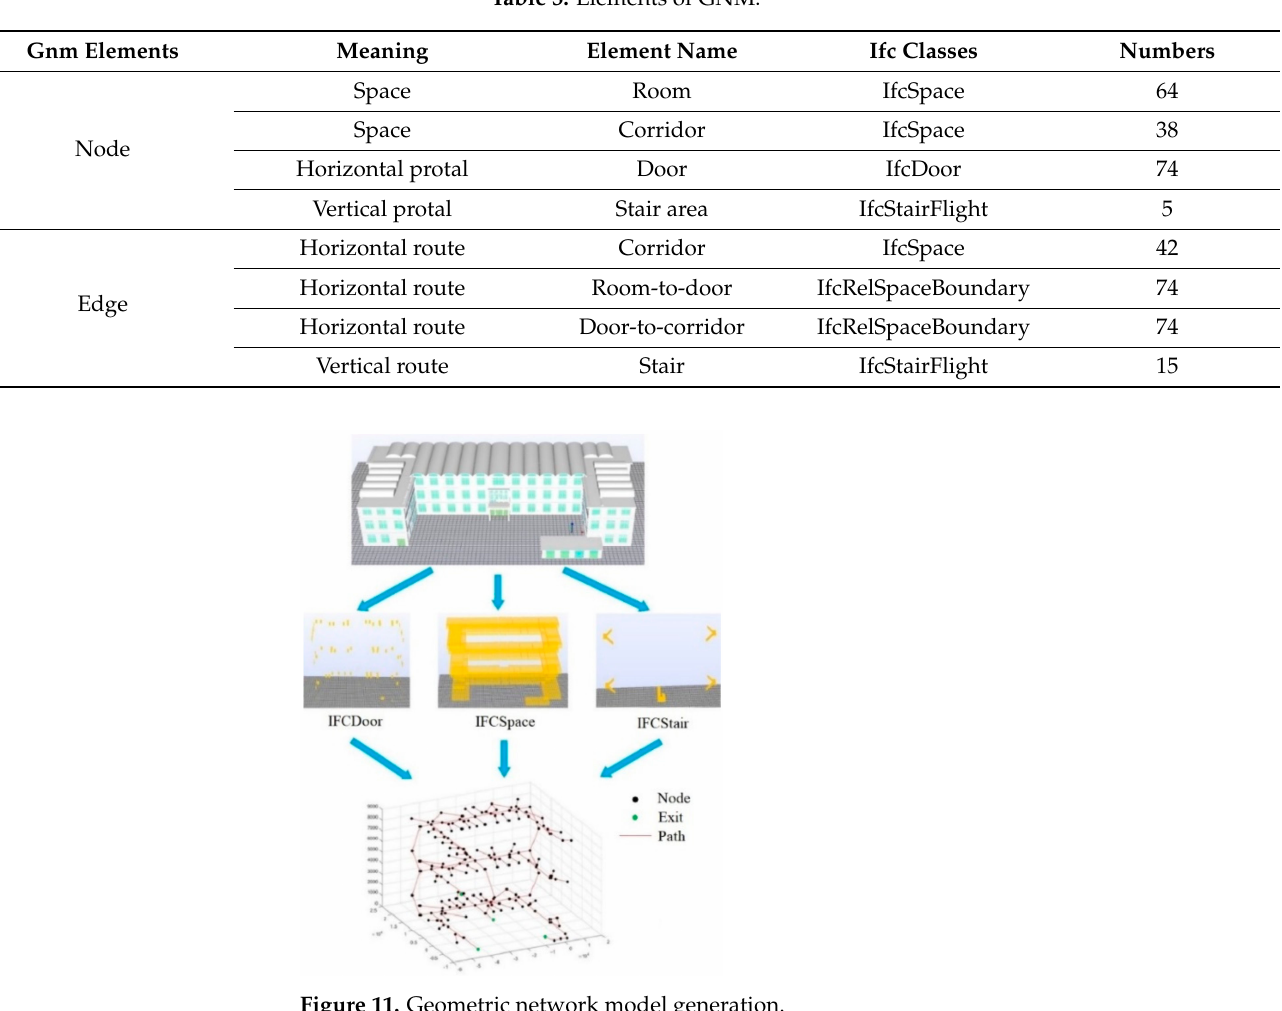
Table 3. Elements of GNM.